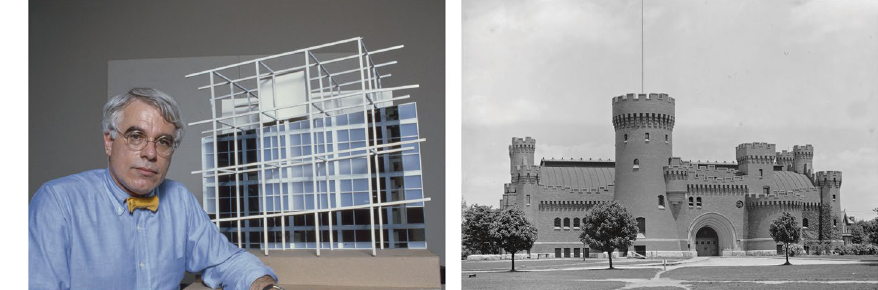
Fig. 2 Left: Peter Eisenman with model of the Wexner Centre for the Arts. Right: the Armory Building, Ohio State University, Columbus (Source: Library of